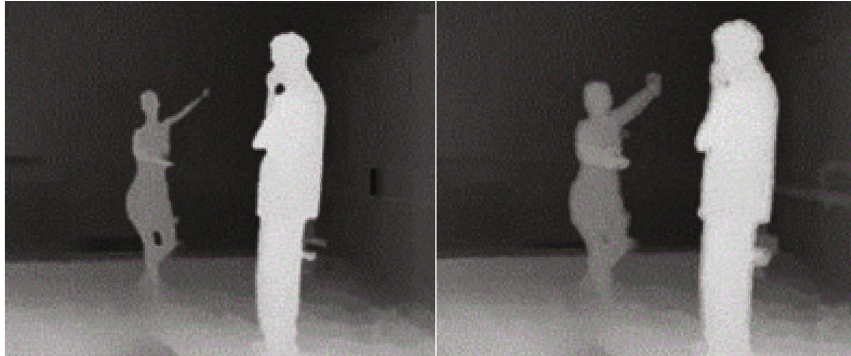
Figure 2: Schematic diagram of image